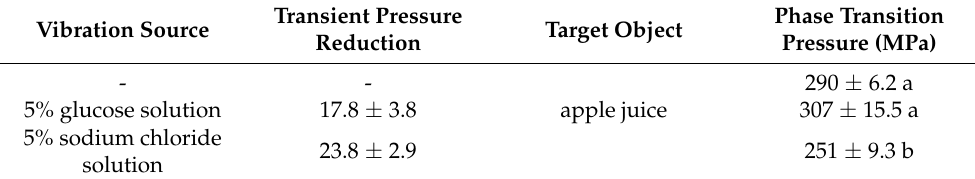
Table 3. The phase transition pressure of apple juice in external vibration